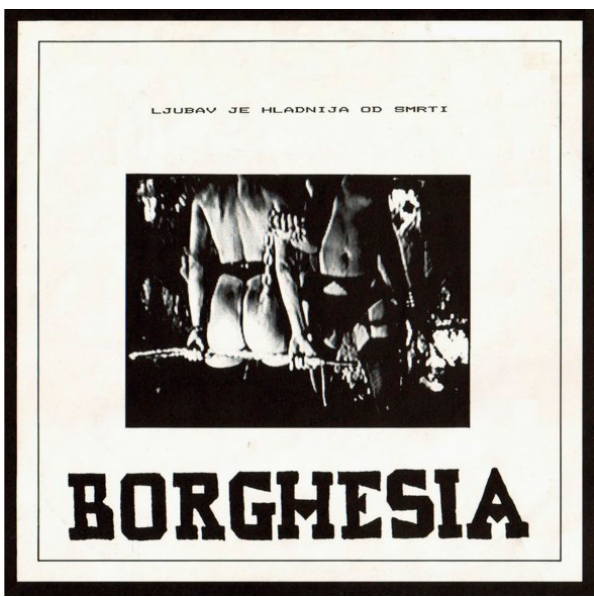
Figure 9. Borghesia, Ljubav Je Hladnija Od Smrti, FV Založba, Totò Alle Prese Coi Dischi, 1985, vinyl, LP.